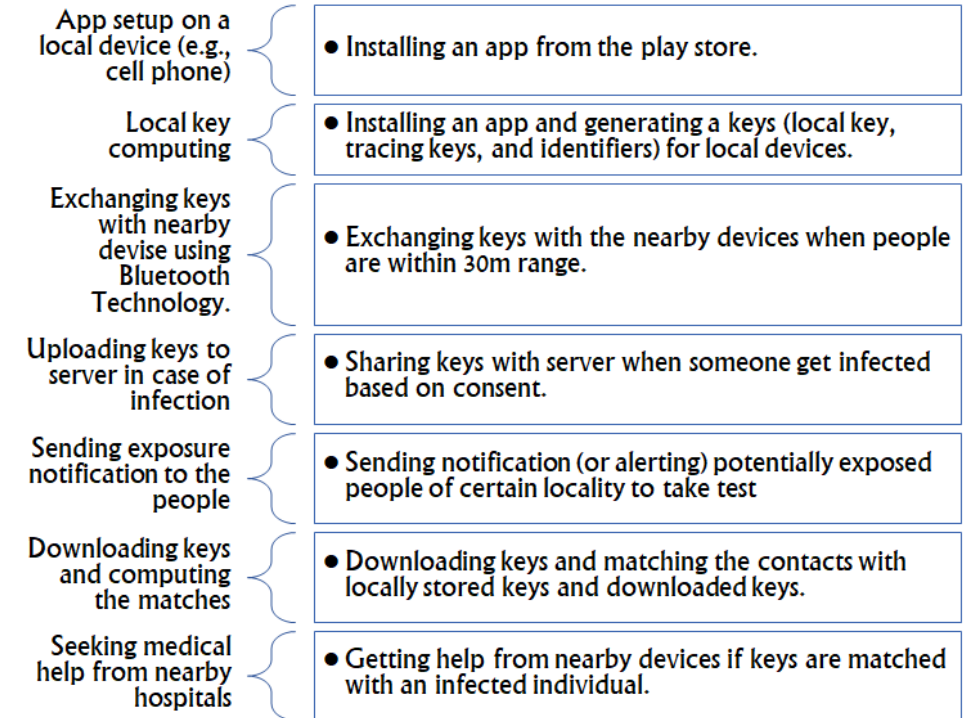
Figure 8. Conceptual overview of main modules of the Apple–Google contact tracing